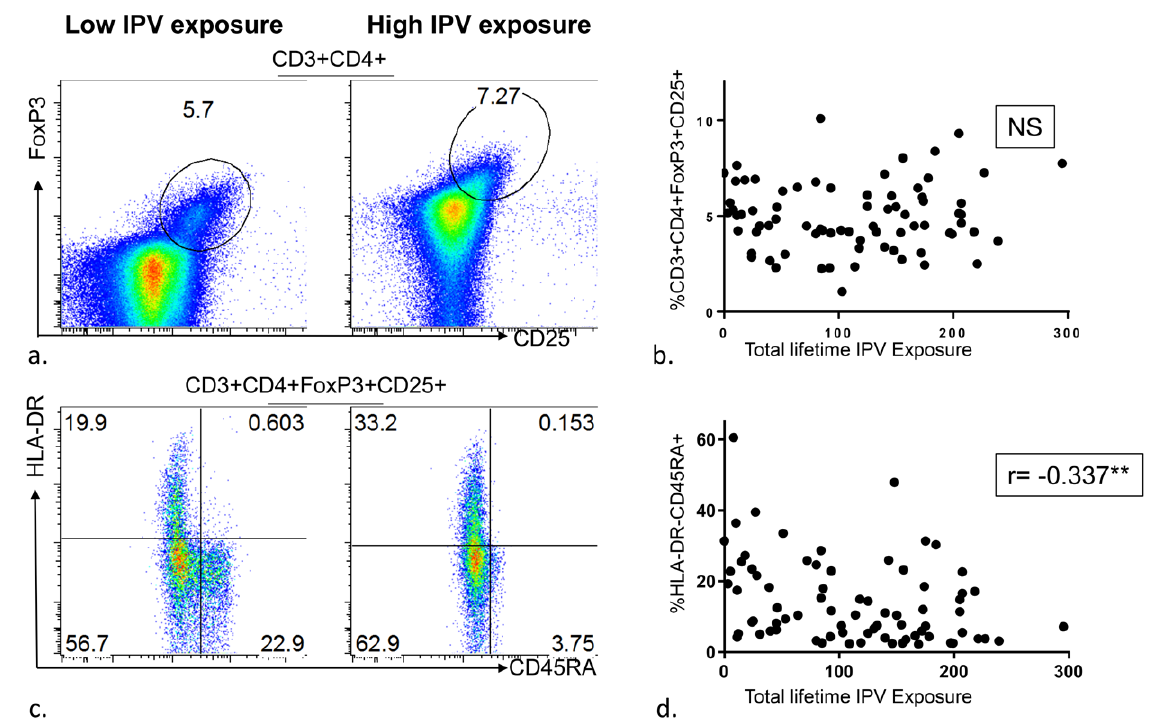
Figure 5. Association between lifetime intimate partner violence (IPV) experience and regulatory (CD4 + Foxp3 + CD25 + ) T-cell frequency and phenotype among HIV high-risk women. (A) Representa- tive flow diagrams demonstrating frequencies of regulatory (CD4 + Foxp3 + CD25 + ) T-cells in the PBMC of two donors with low versus high reporting of lifetime IPV experience. (B) Summary data from 75 HIV high-risk women demonstrating lifetime IPV experience was not significantly associated with frequency of regulatory (CD4 + FoxP3 + CD25 + ) T-cells in PBMC. (C) Representative flow diagrams depicting frequencies of regulatory (CD4 + FoxP3 + CD25 + ) T-cell phenotypes using CD45RA and HLA-DR markers in the PBMC of two donors with low versus high reporting of lifetime IPV experience. (D) Summary data from 75 HIV high-risk women demonstrating lifetime IPV experience is negatively associated with the frequency of naïve regulatory T-cells (HLA-DR - CD45RA + CD4 + FoxP3 + CD25 + ) in